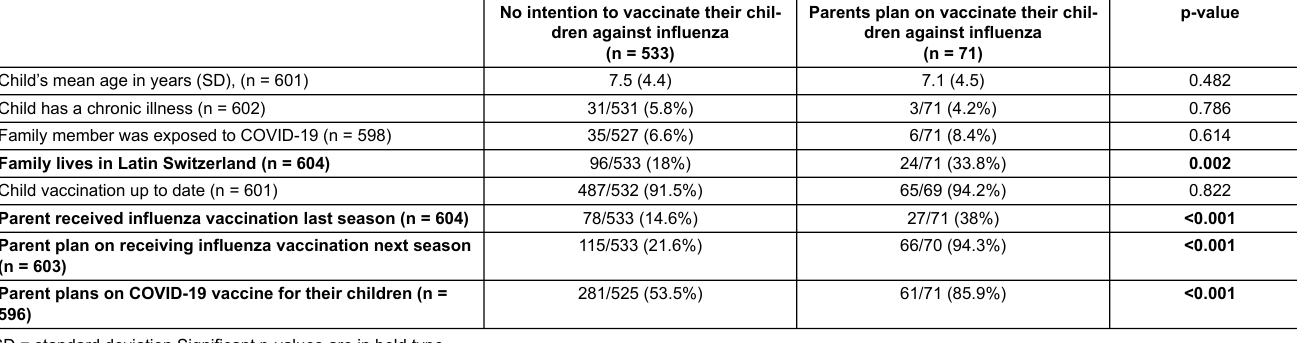
Table 3: Factors associated with parents not vaccinating their children against influenza last